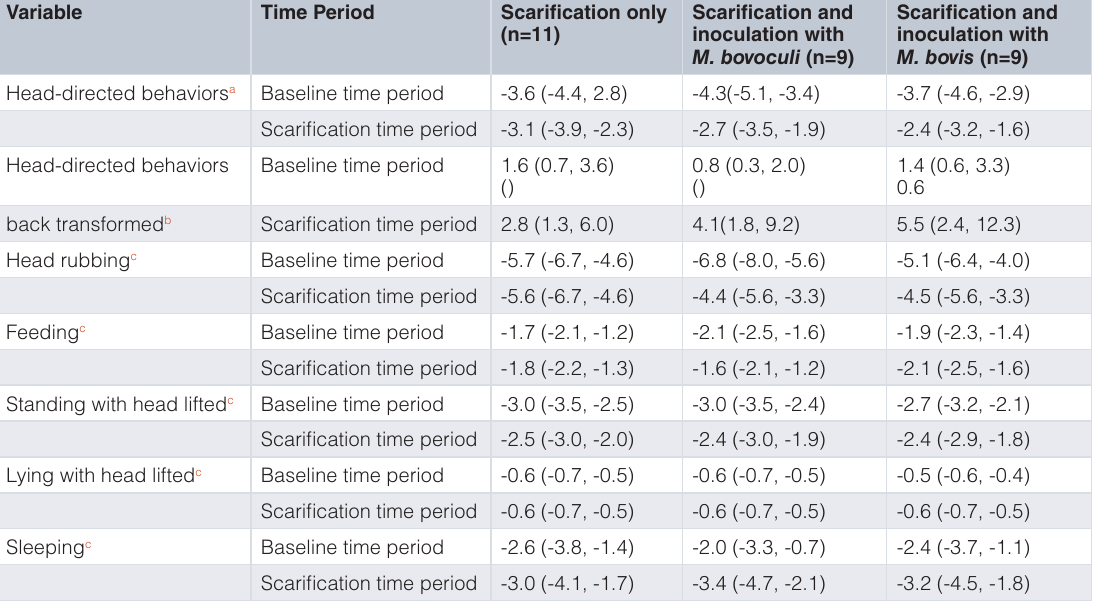
Table 5. Estimates (95% confidence interval) in log units of all six models of pain and sickness behaviors for the three treatments during baseline and scarification time periods. Head-directed behaviors are events in units of log of link. Head-directed behaviors back transformed are in units of frequency of event per hour. Head rubbing, feeding, standing with head lifted, lying with head lifted and sleeping are behavioral states in units of log of